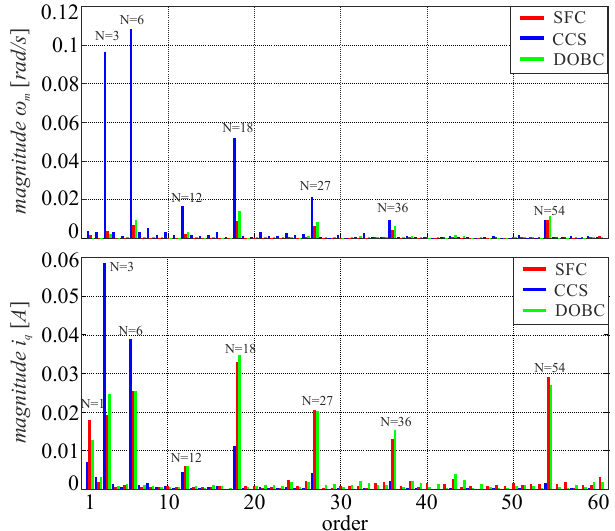
Figure 8. Frequency spectrum of angular velocity and quadrature current component for a set reference of 5 rad/s.